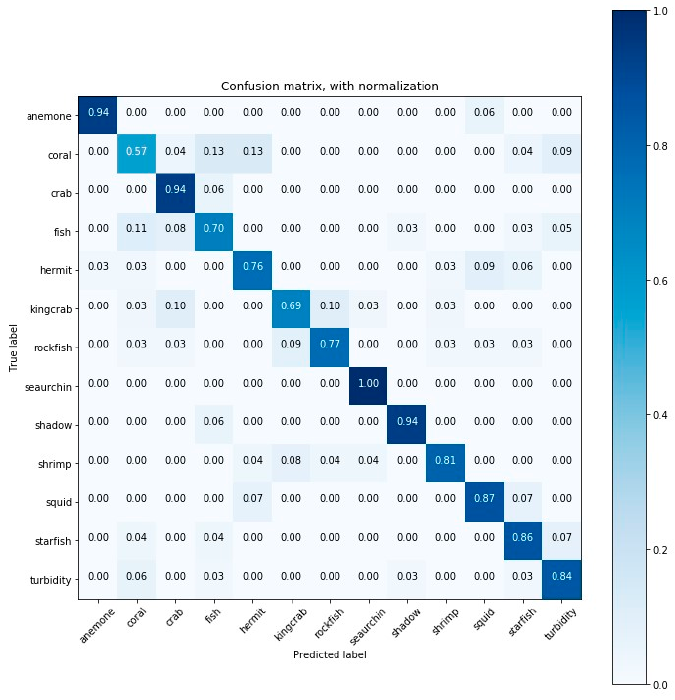
Figure A14. Confusion matrix for the classification results (accuracy) obtained by DNN-4.